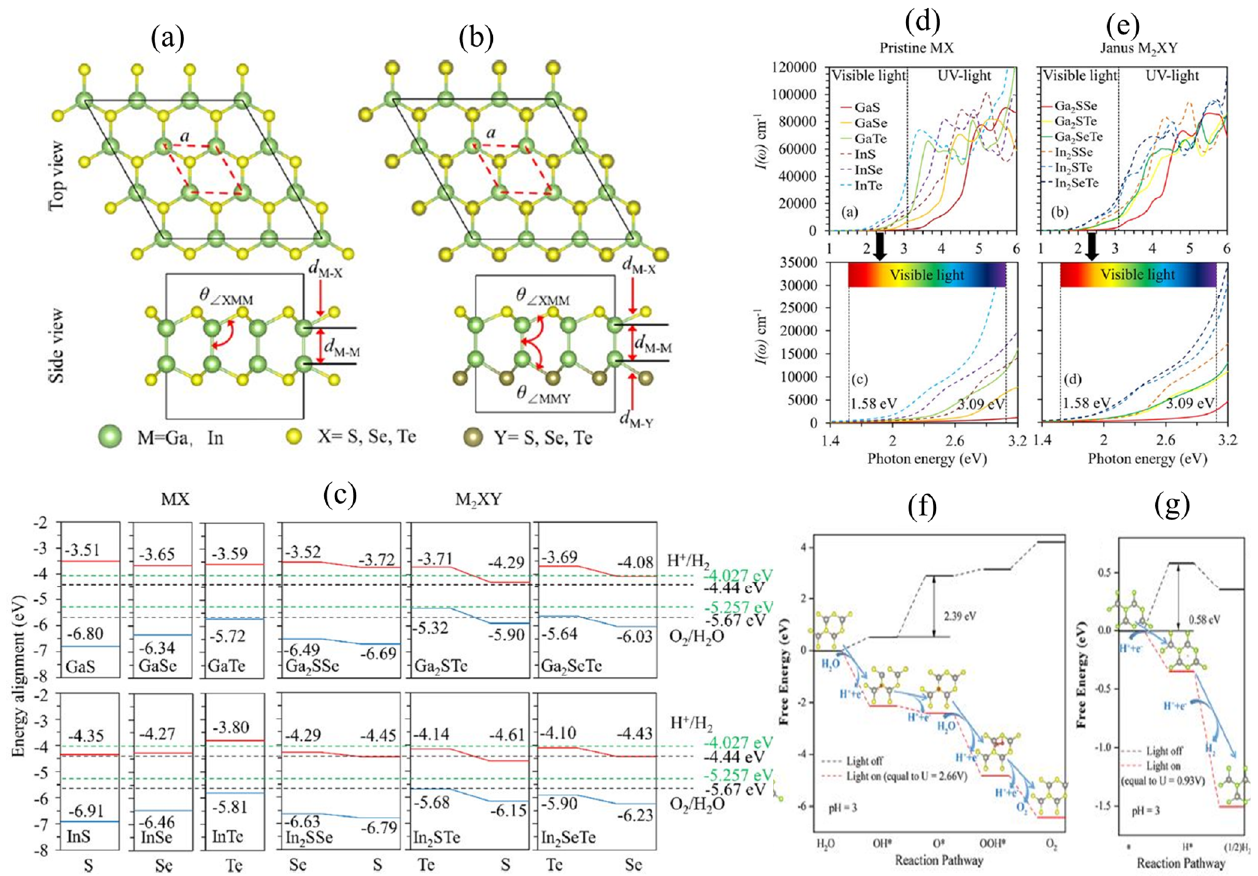
Figure 9. The geometric structure of the 2D ( a ) MX and ( b ) Janus M 2 XY monolayers and their ( c ) electronic band edge positions relative to the vacuum level. Reprinted with permission from ref. [186]. Copyright 2019 ACS. The optical absorption coefficients I(ω) and in the visible light region for the 2D ( d ) MX and ( e ) Janus M 2 XY monolayers. ( f ) OER and ( g ) HER at pH = 3 on the WSSe monolayer under different illumination conditions, respectively. The grey and red balls separately are the H and O atoms. Reprinted with permission from ref. [108]. Copyright 2020 ACS.